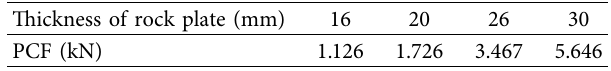
Table 4: The PCF of granite with different thickness. Thickness of rock plate (mm)